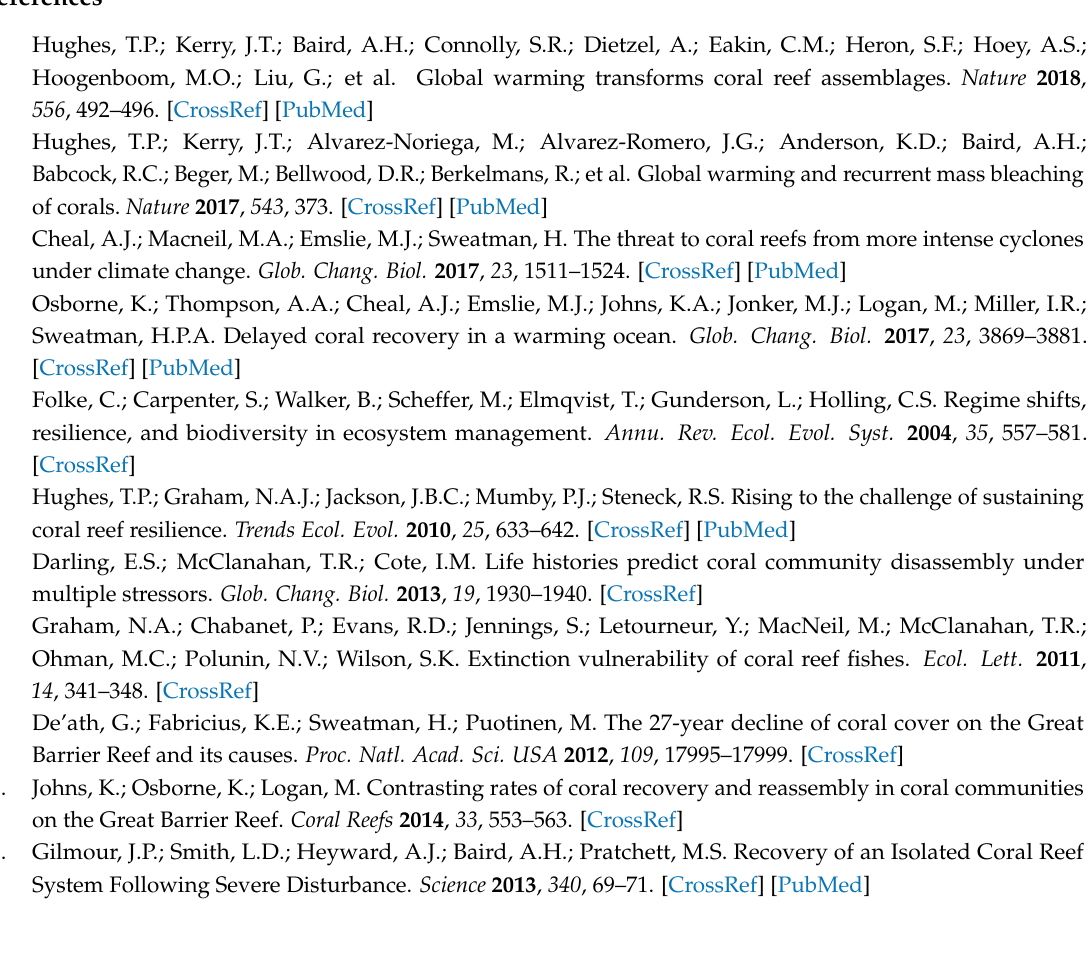
Figure S1: Calculation of the Bray–Curtis distance to pre-disturbance communities from the 1996–2017 time series: example of the first three reefs in the dataset, Figure S2: Interaction plots for the hierarchical linear models, Figure S3: Multicollinearity among water quality indices, Figure S4: Trace plots for posterior parameter estimates, Figure S5: Distribution of hard coral cover in pre-disturbance years across shelf